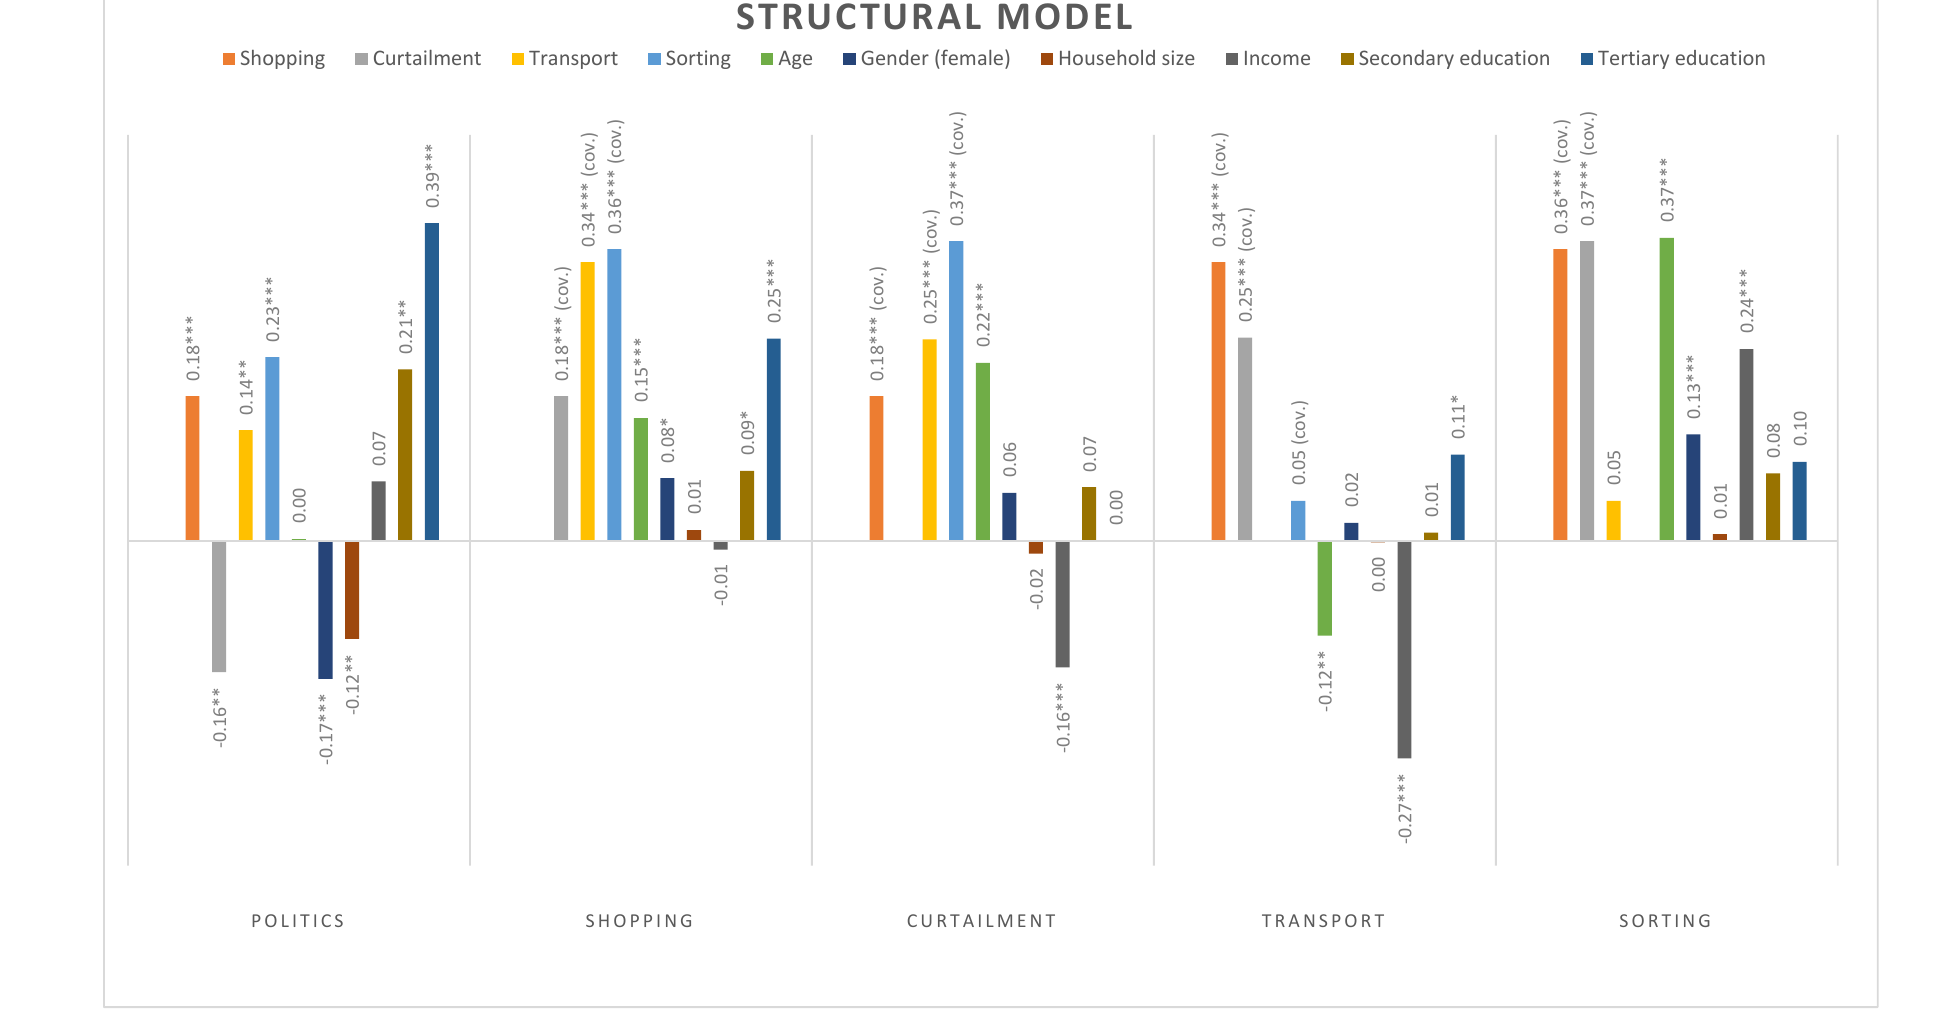
Figure 3. Regression coefficients. For significance, the following standards were applied: * p < 0.05; ** p < 0.01; *** p < 0.001.